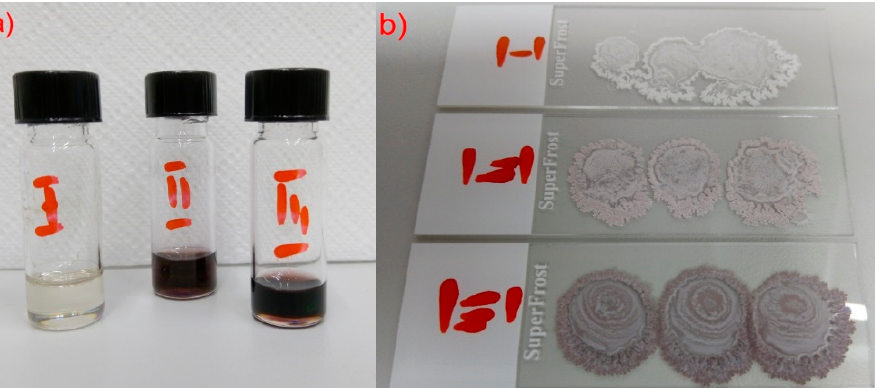
Figure 16. Composites as solutions (in 2ml toluene) ( a ) and after evaporation on the microscopic slides ( b ): I—Composite 1, II—Composite 2, and III—Composite 3.